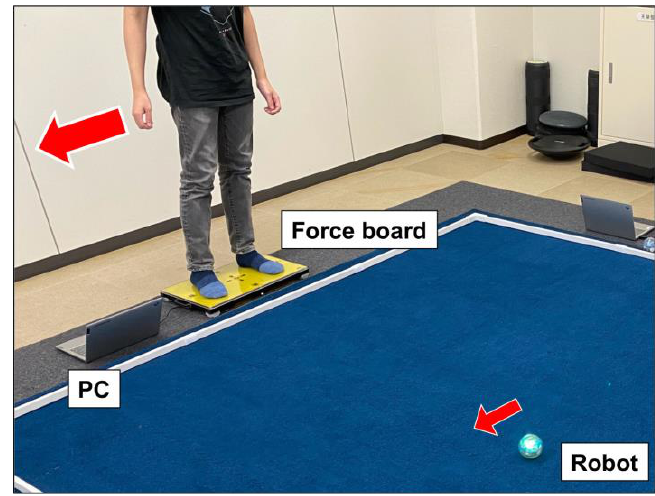
Figure 1. Newly developed weight-shifting-based robot control system (LOCOBOT, locomotion robot). Users stand on a force board and can move the spherical robot freely on a floor through weight shifting. The laptop PC is connected to the force board and measure forces of the loadcell placed on each corner and the center of pressure (COP) is calculated; then, the robot is wirelessly moved in the direction based on COP.